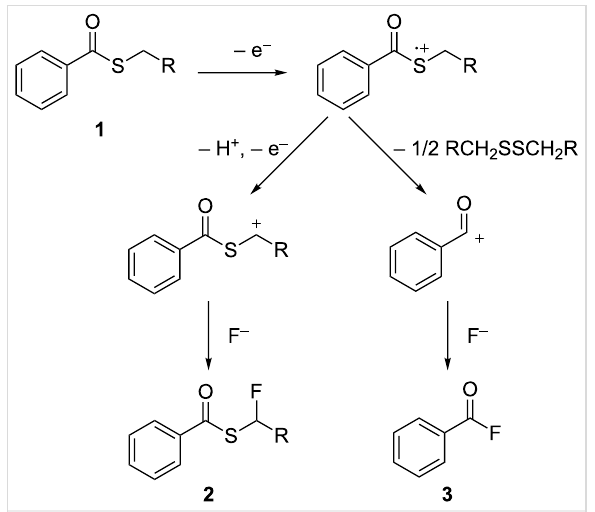
Scheme 5: General reaction mechanism for the anodic fluorination of 1 .